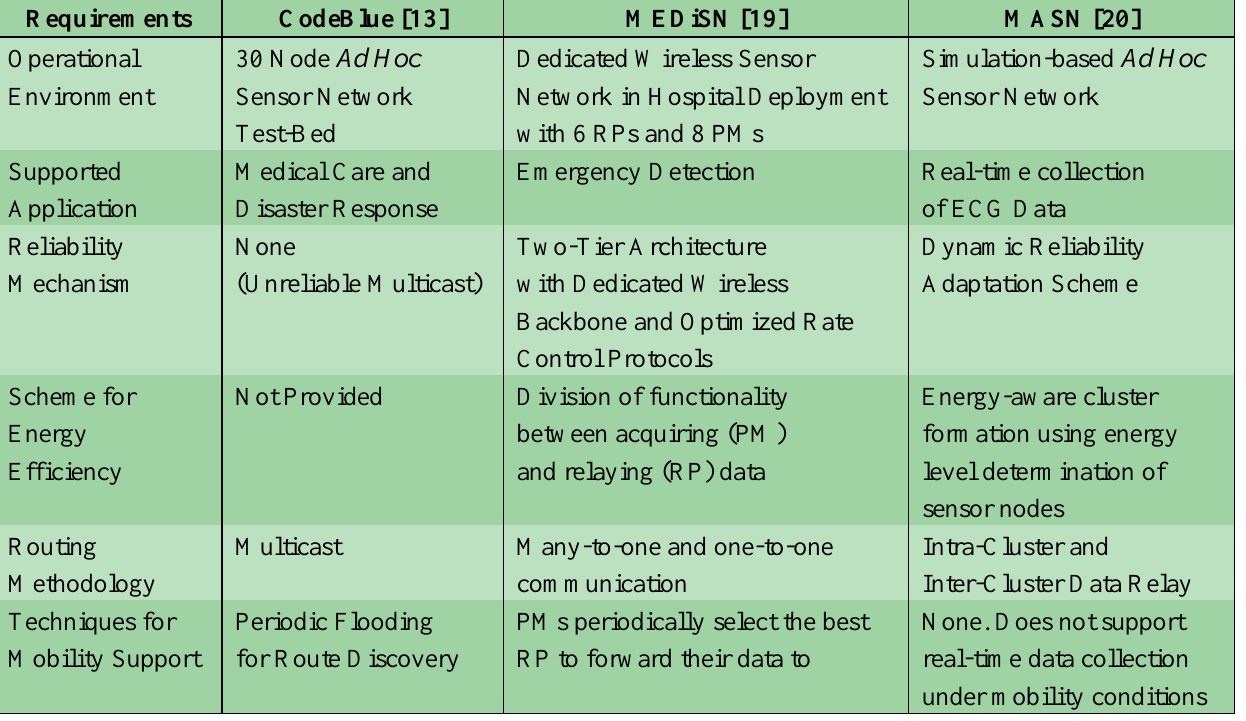
Table 1. Characteristics of CodeBlue, MEDiSN and MASN